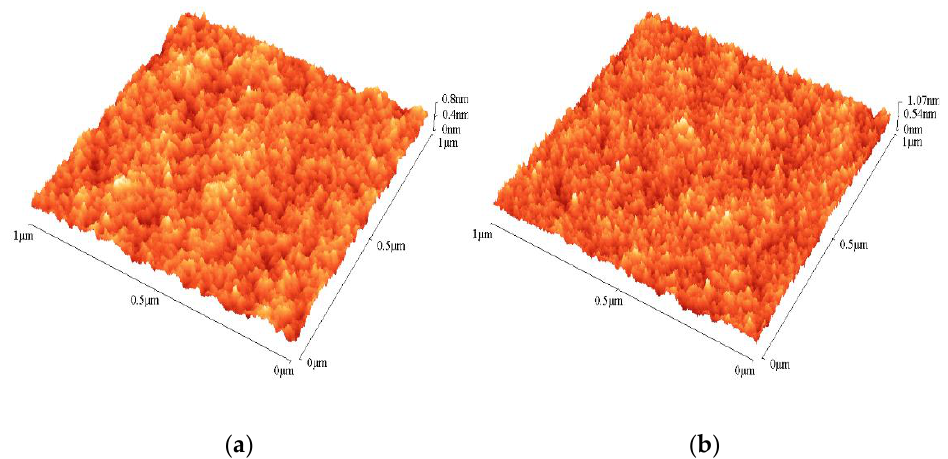
Figure 2. AFM images: ( a ) HAp + Mg + Si_RT and ( b ) HAp + Mg + Si_200 coatings deposited on Si waffers.